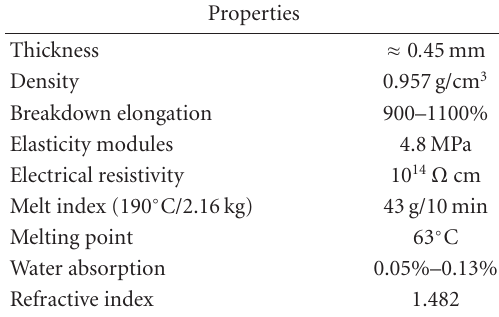
Table 2: EVA properties